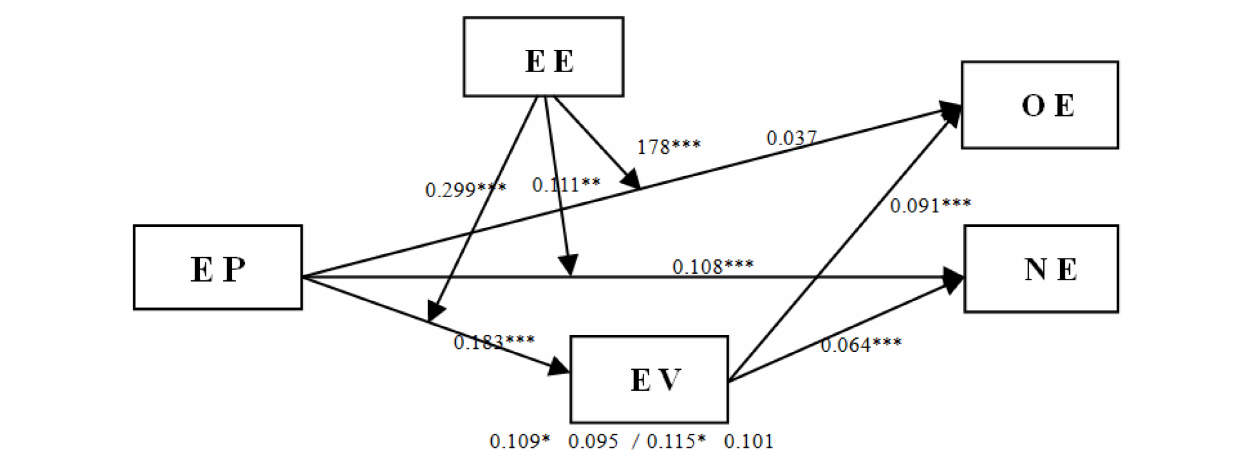
FIGURE 2 | Findings for the structural equation model. Abbreviations: EP, employment pressure; EV, entrepreneurial values; EE, entrepreneurial environment; OE, opportunity entrepreneurship; NE, necessity entrepreneurship. *** p < 0.001, ** p < 0.01, * p <